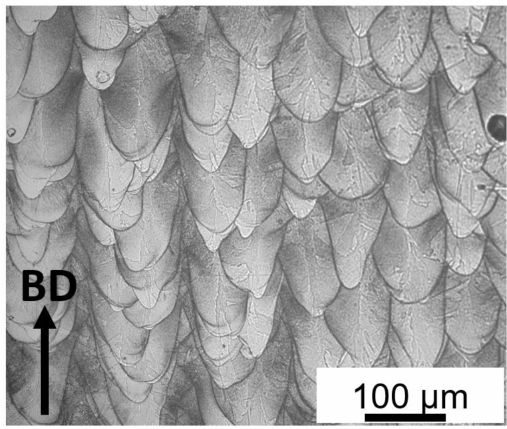
Figure 8. OM image of as-built micro-LPBF Inc718.